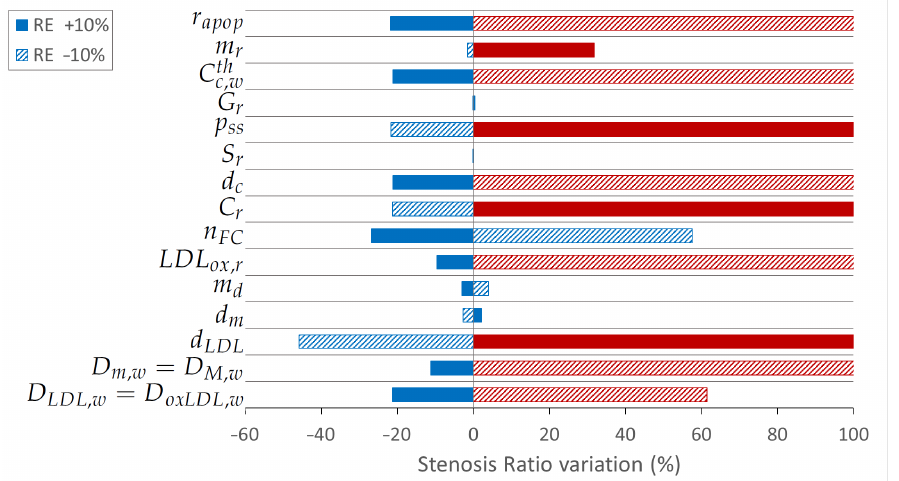
Figure 5. Variation of the stenosis ratio (blue color) when increasing and decreasing the parameters by 10% (solid and striped colors, respectively). Bars in red represent a variation of one of the substances higher than